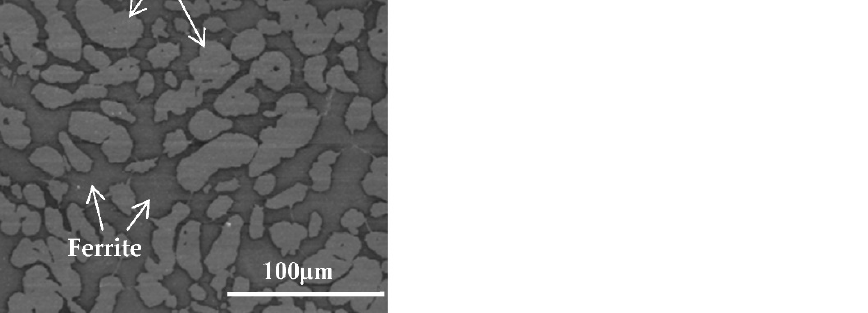
Figure 1. SEM ‐ SE microstructure of S32750 SDSS at 1000×; the darker phase is ferrite and the brighter phase is austenite.